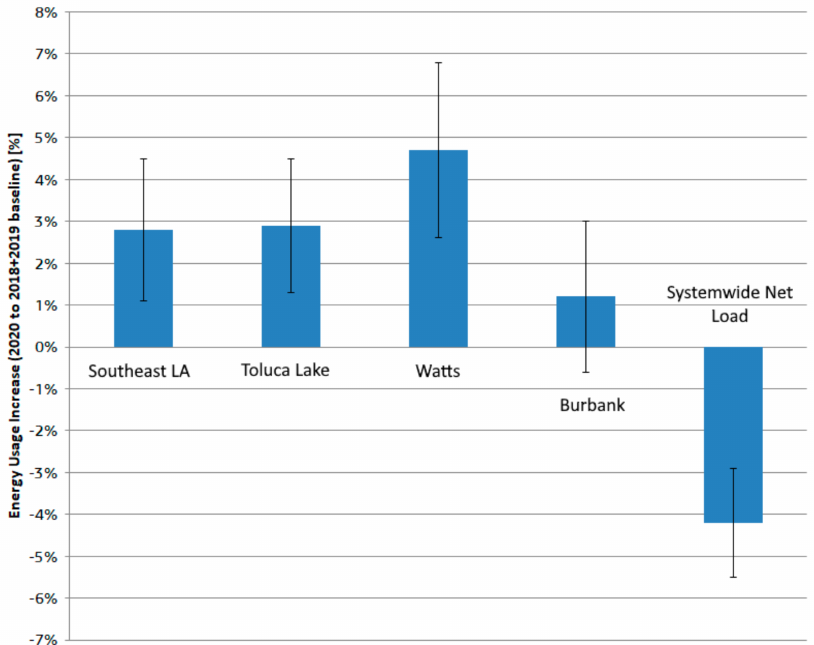
Figure 5. Total estimated non-temperature sensitive energy change during the COVID-19 pandemic period compared to a 2018–2019 comparison baseline for each analyzed feeder in addition to system wide LADWP NPL load. Error bars represent 80% CI bounds propagated.